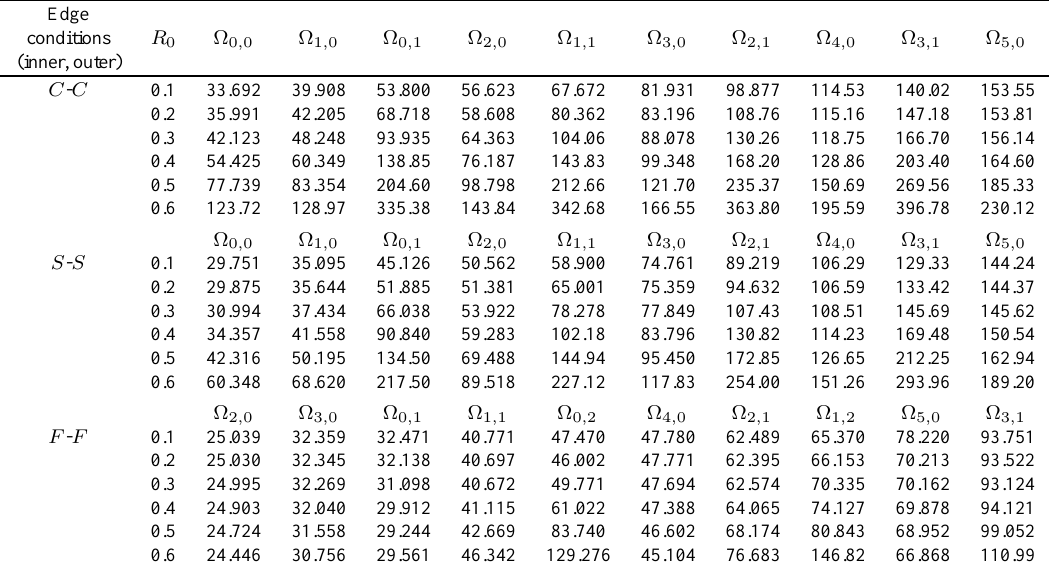
Table 8 Variation in Ω m,n with R 0 for C - C , S - S and F - F plates when α = β = 0 . 5 ,e r = g r = 5 . 0 and K f =